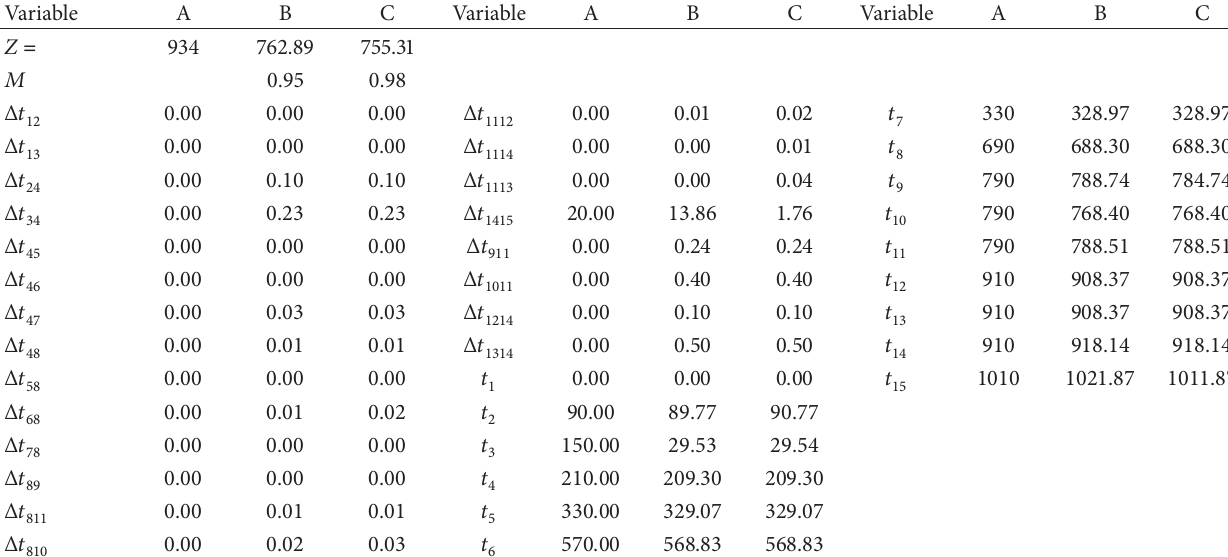
Table 5: Solutions of the Zimmermann’s approach and fuzzy SA model for threshold 𝛼 = 0.98 .